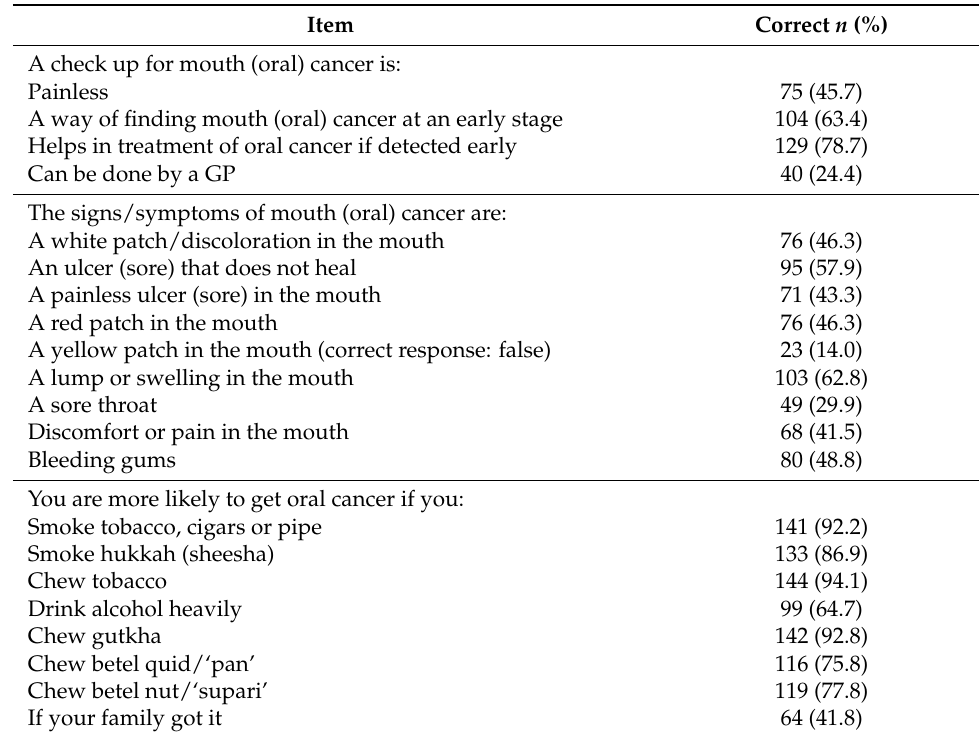
Table 3. Knowledge items and correct responses.